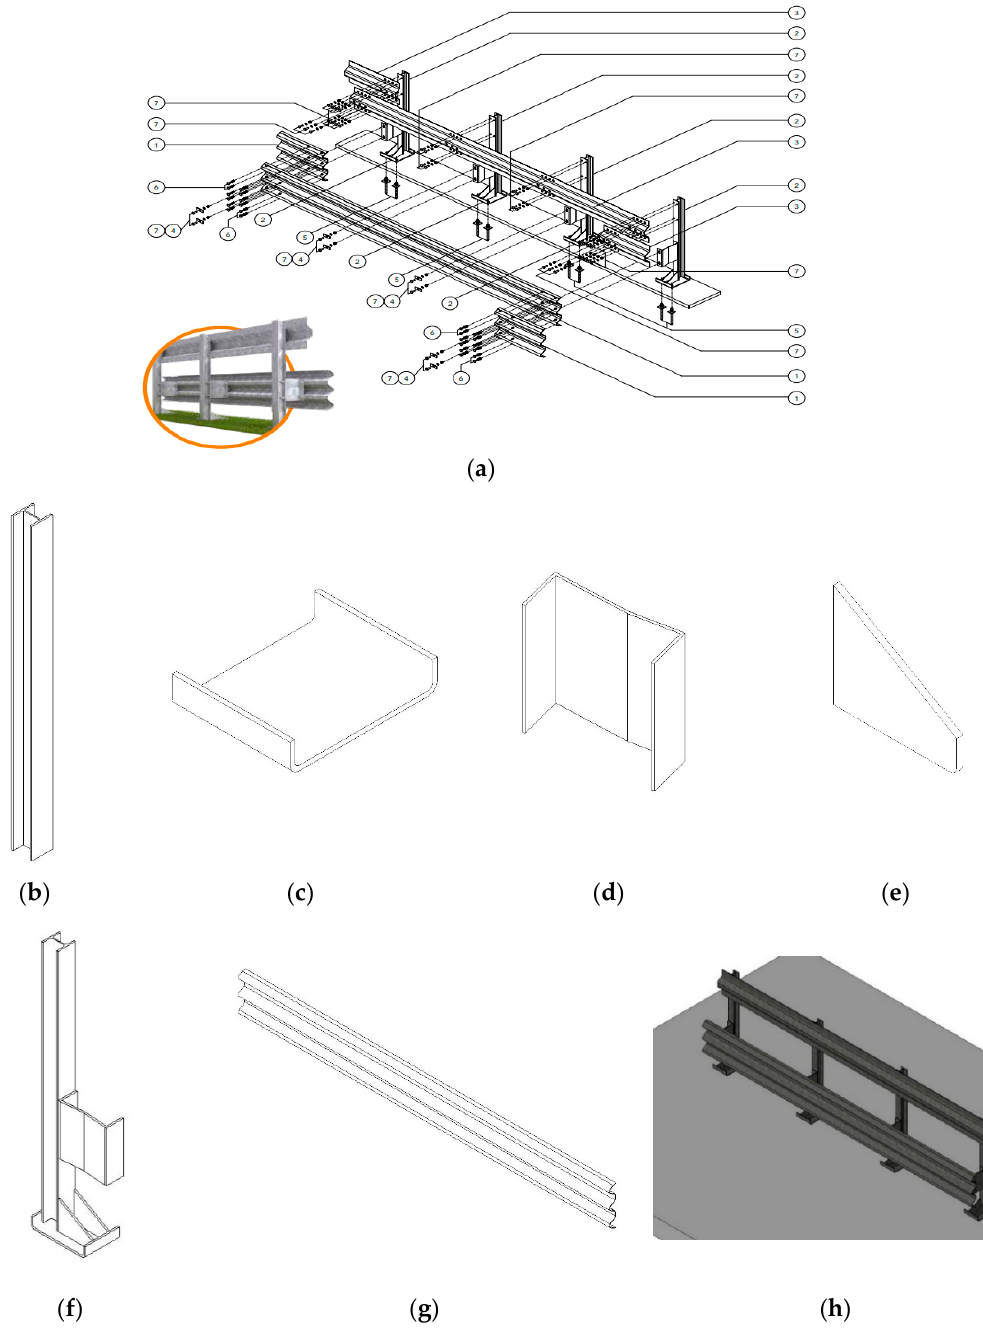
Figure 6. Bridge side guardrail modeled: ( a ) bridge side guardrail produced by Marcegaglia Company; ( b ) post; ( c ) base plate; ( d ) post spacing; ( e ) base plate stability element; ( f ) complete post; ( g ) 3-waves beam; ( h ) 3D model view.